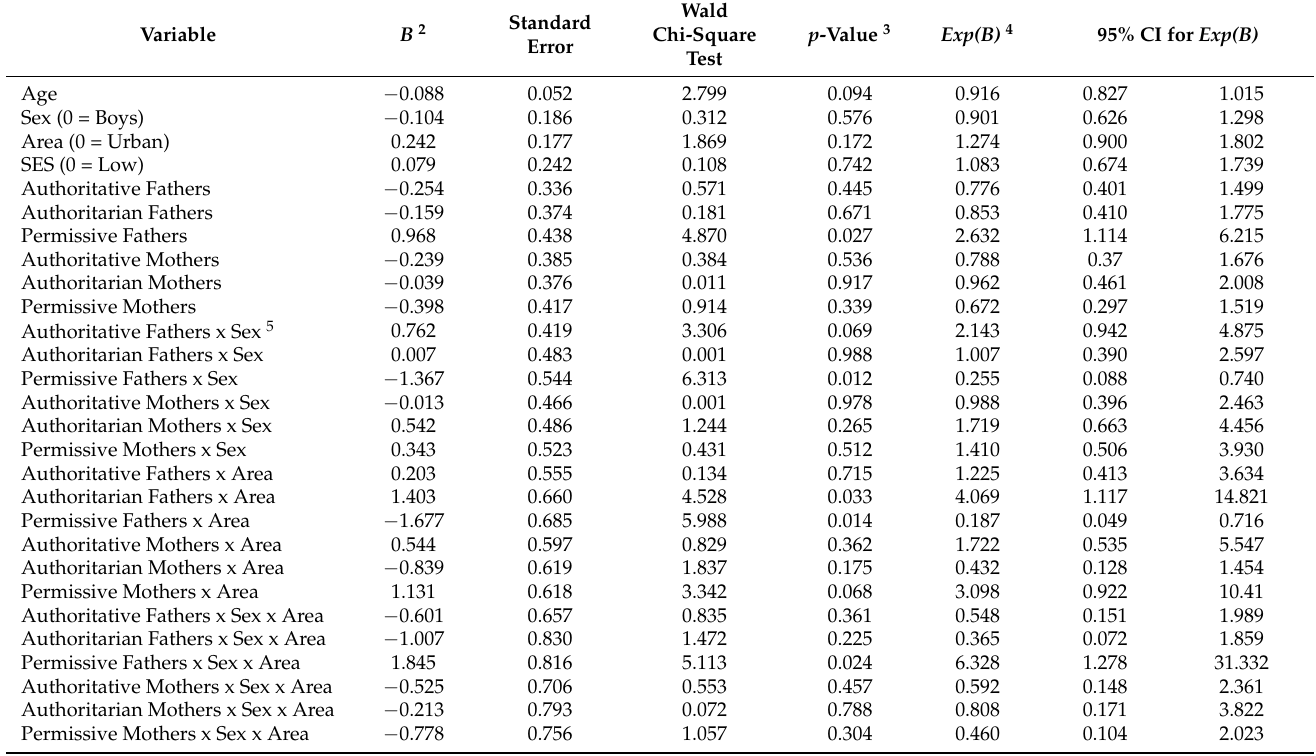
Table 3. Summary of hierarchical logistic analyses predicting the influence of fathers’ and mothers’ parenting styles on overweight among urban and rural Costa Rican adolescents ( n = 695) 1